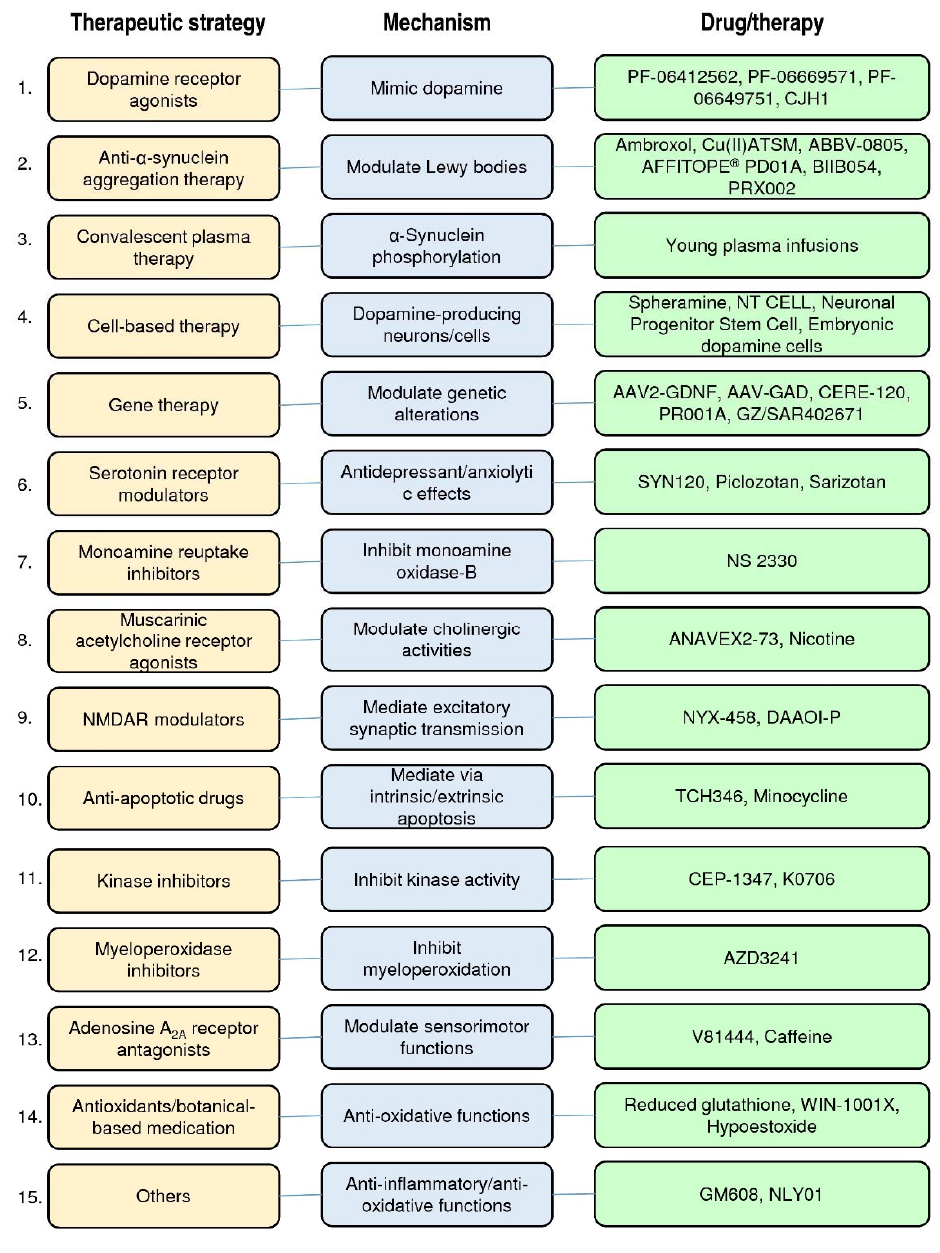
Figure 3. The type of therapeutic strategies, mechanism, and the current drugs/therapies in the clinical trials of PD treat-